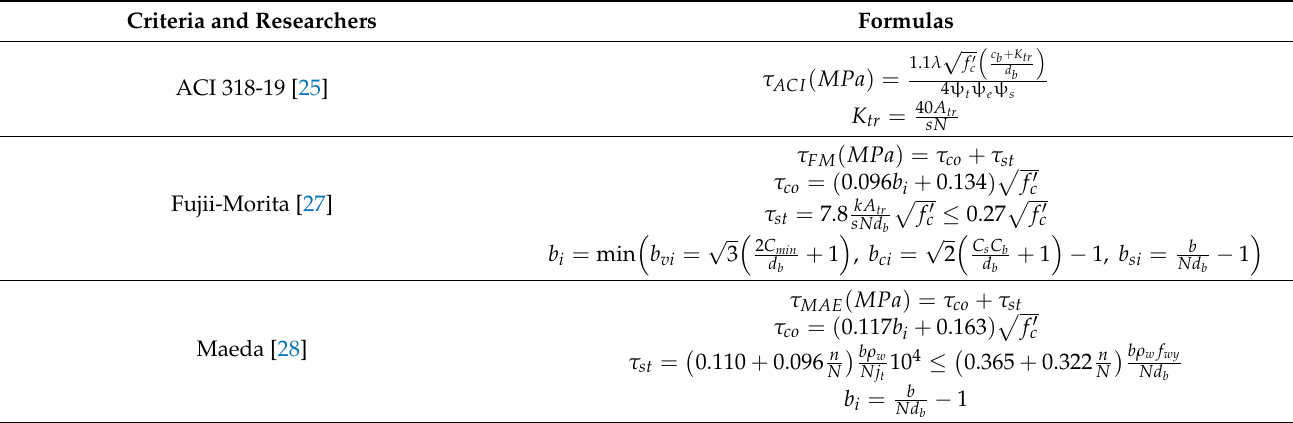
Table 6. Model for bond